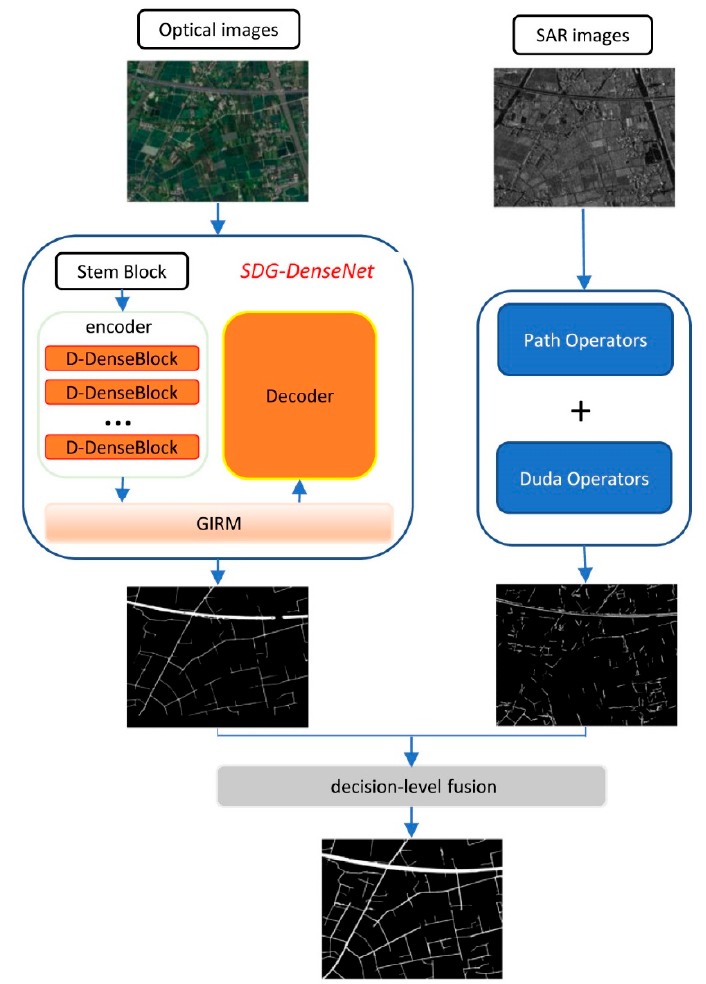
Figure 1. The overall technical flow of the proposed method.